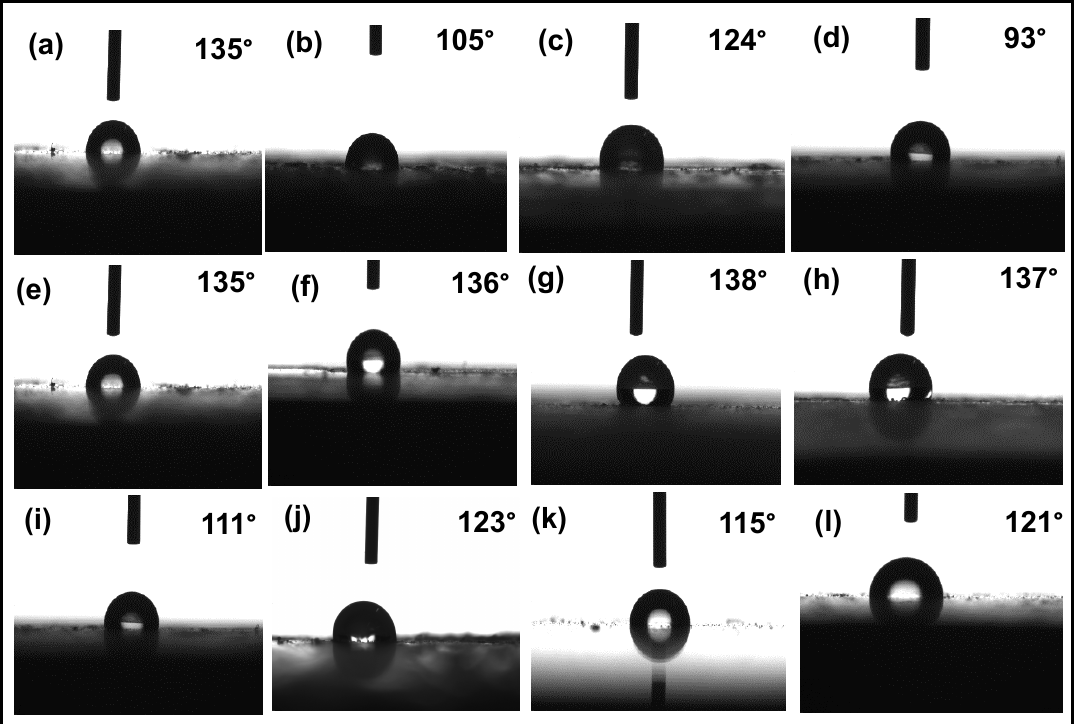
Figure 2. Photographs of water droplets on SBA coated floor tiles at ( a ) pH 3, ( b ) pH 5, ( c ) pH 7, ( d ) pH 10. Water contact angle (WCA) of SBA coated substrates ( e ) tiles, ( f ) brick, ( g ) glass, ( h ) cotton fabric. WCA of SBA coated substrates after 30 days under open air conditions ( i ) tiles, ( j ) brick, ( k ) glass, and ( l ) cotton fabric.